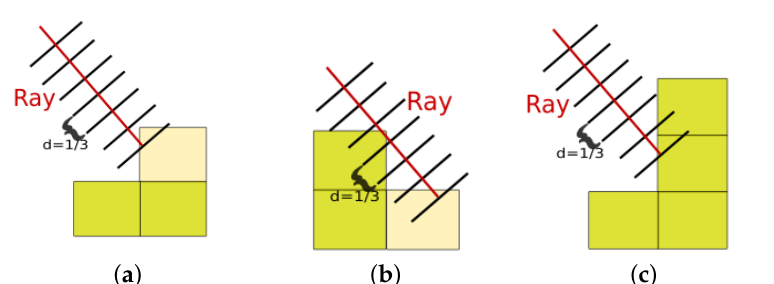
Figure 4. The lighter color visualizes which voxel is being measured. In the figures, the number of steps per voxel is u = 3. From the left: ( a ) The belief of the upper voxel is updated. ( b ) Edge case: the ray is going through the upper voxel but the belief of the right lower voxel is updated. ( c ) No voxel is updated because the surface was not hit by a